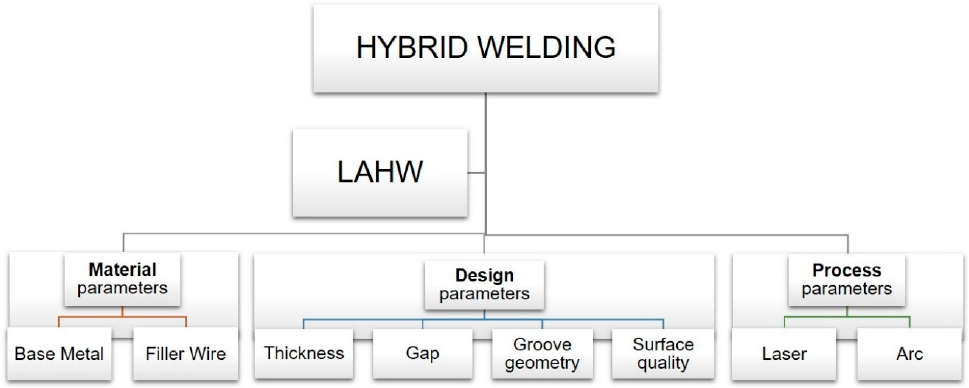
Figure 4. Flow chart of main parameters in LAHW.